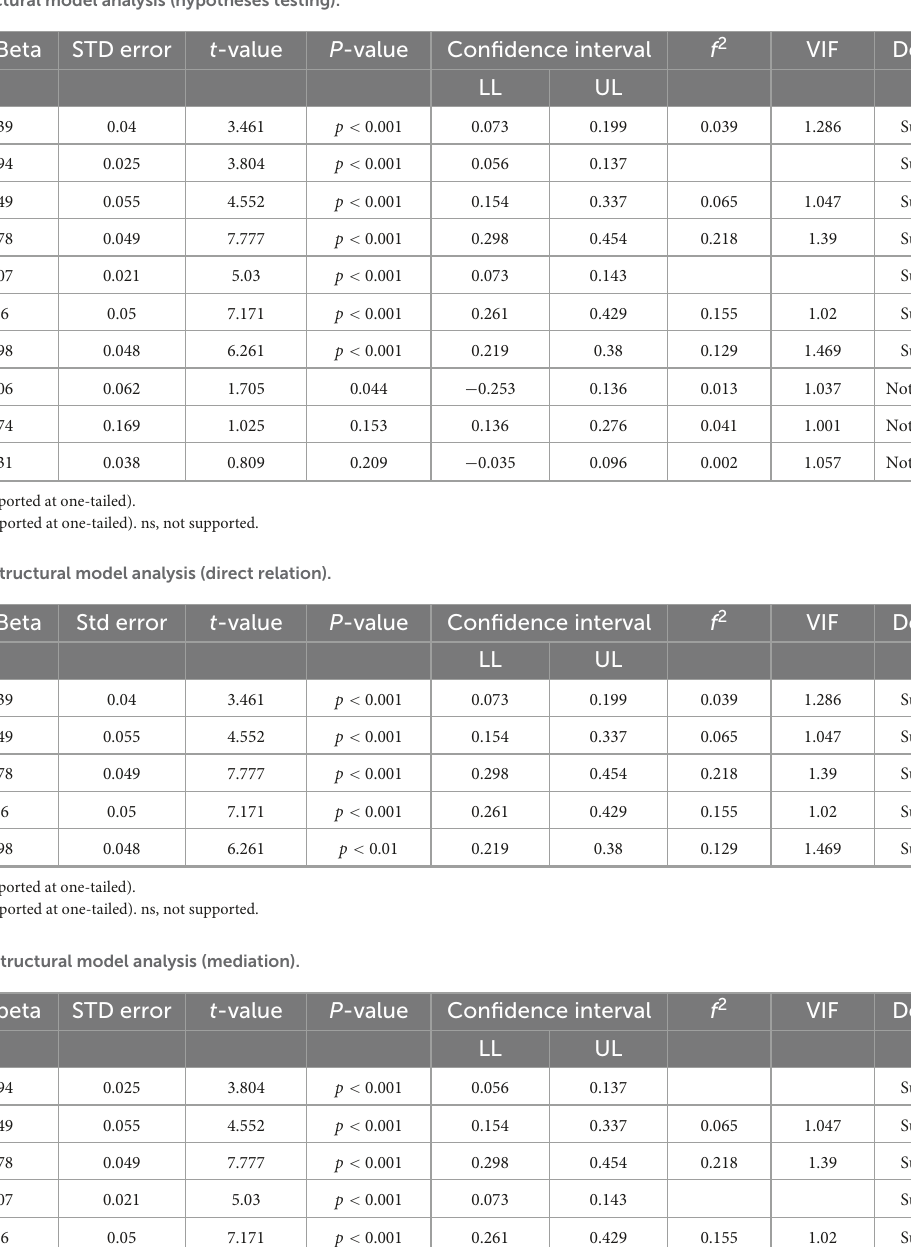
TABLE 6 Results of structural model analysis (hypotheses testing).